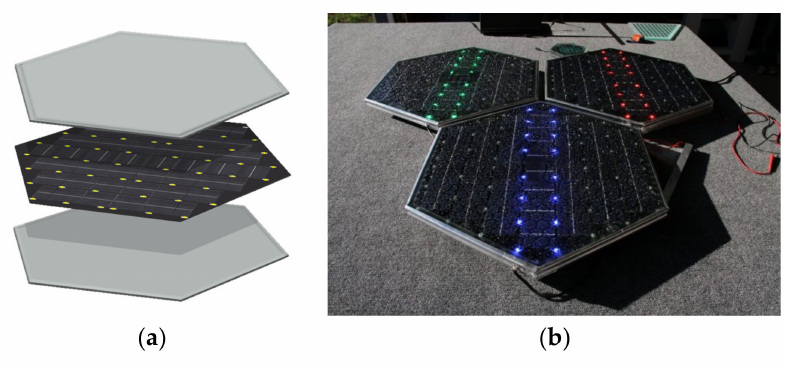
Figure 3. SR1 prototype; ( a ) schematic drawing; ( b ) actual panel (Brusaw, 2016).